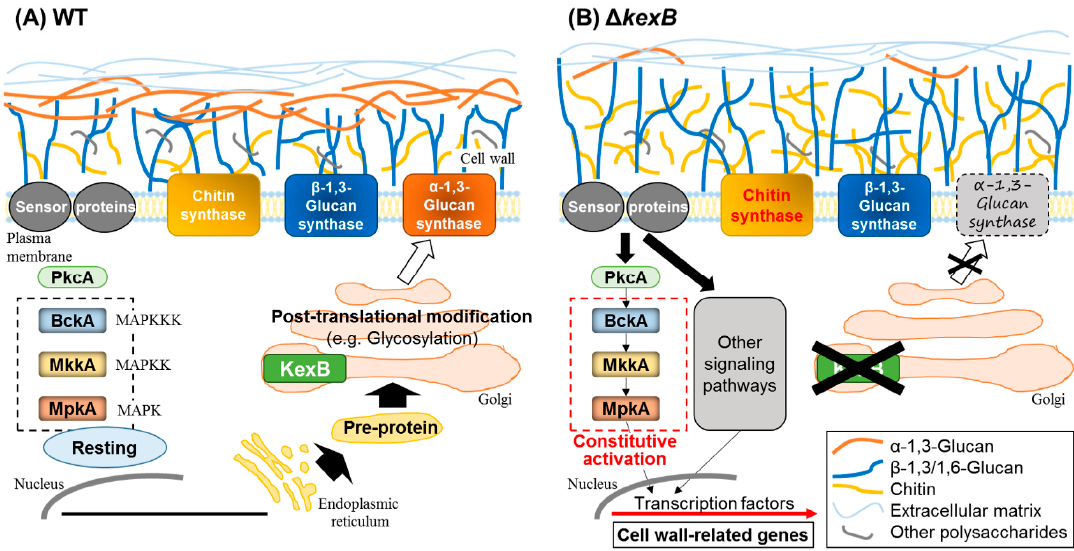
Figure 1. Maintenance of cell wall integrity by KexB in Aspergillus oryzae . KexB is predicted to be required for correct proteolytic processing of sensor proteins and cell wall–related enzymes, including α -1,3-glucan synthase. ( A ) In the wild-type (WT) strain, the cell wall integrity MAP kinase pathway (dashed square) is not activated (resting) under normal growth conditions (no cell wall perturbation). Pre-protein is transported from the endoplasmic reticulum to the Golgi apparatus, and is subsequently modified (e.g., glycosylated). ( B ) In the Δ kexB strain, the cell wall integrity pathway is constitutively activated, resulting in a substantial decrease in cell wall α -1,3-glucan. This decrease upregulates the transcription of cell wall–related genes and is compensated by an increase in chitin content and an increase in the degree of β -1,3-glucan polymerization. The crosses indicate no-function.